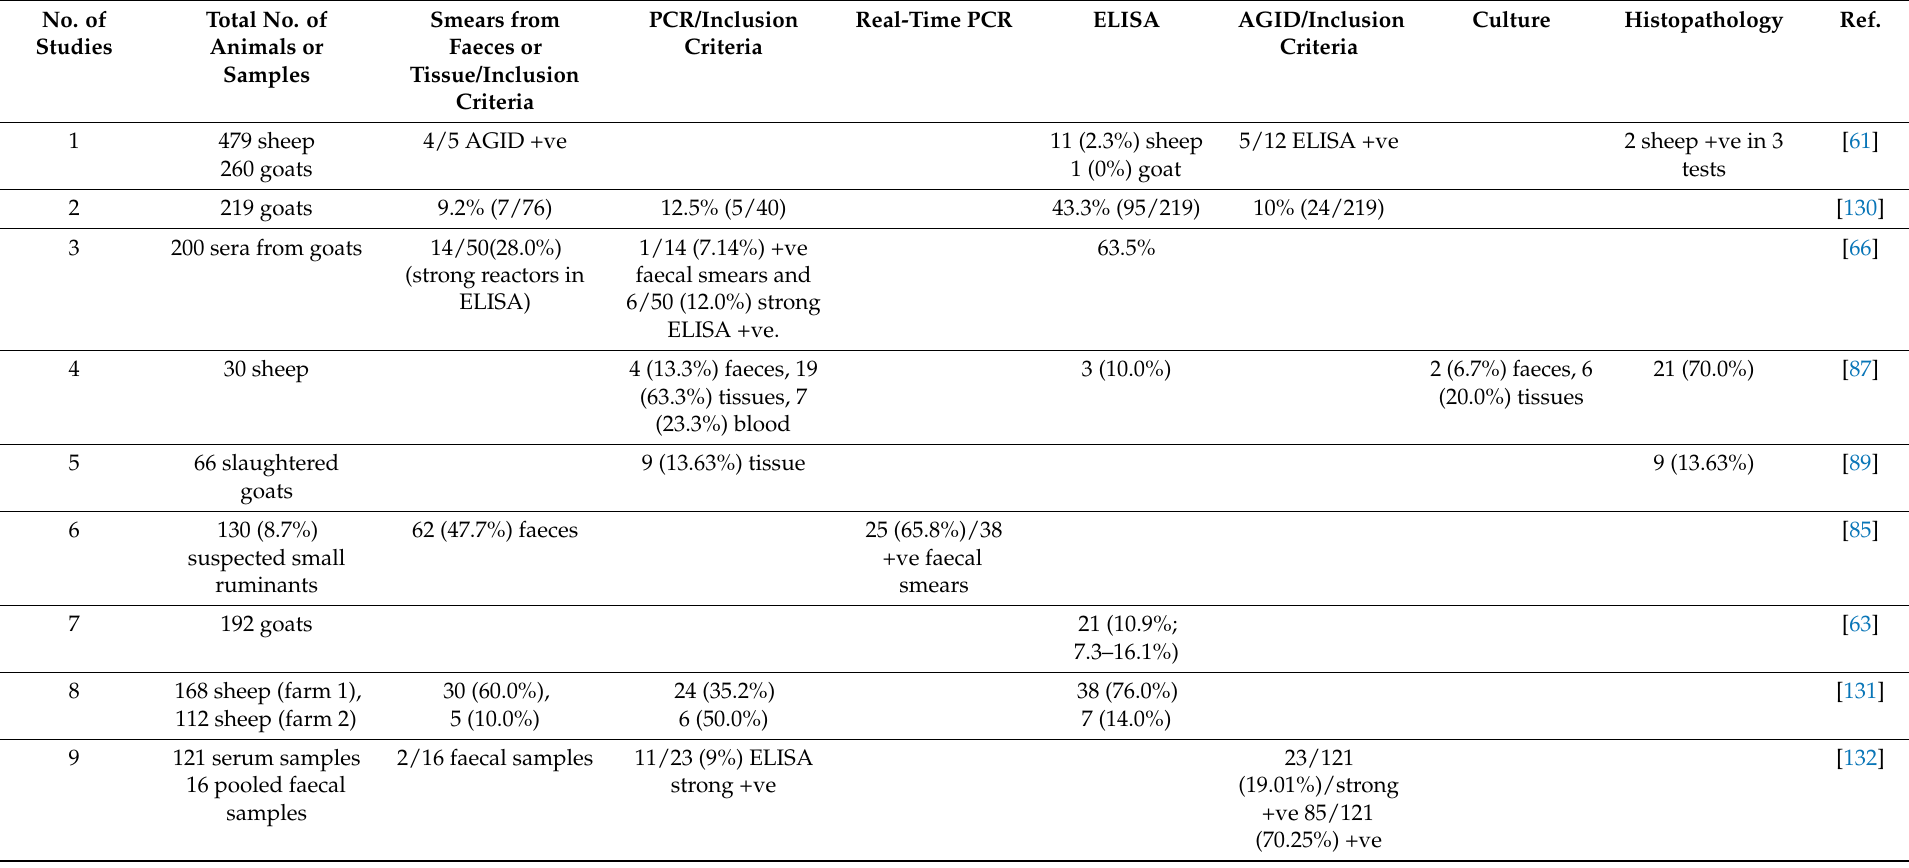
Table 1. Diagnosis of paratuberculosis in small ruminants using different techniques